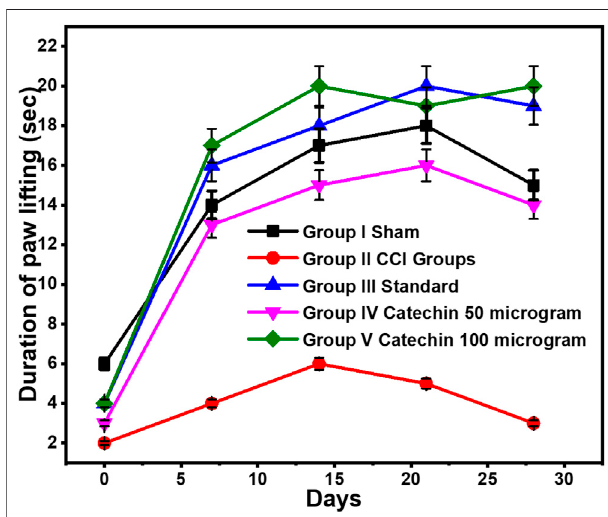
FIGURE 1 | Assessment of spontaneous pain using a neutral plate. Values are expressed as mean ± SEM for six animals in each group. Signi fi cance was determined by ANOVA. p < 0.001 when compared with sham and